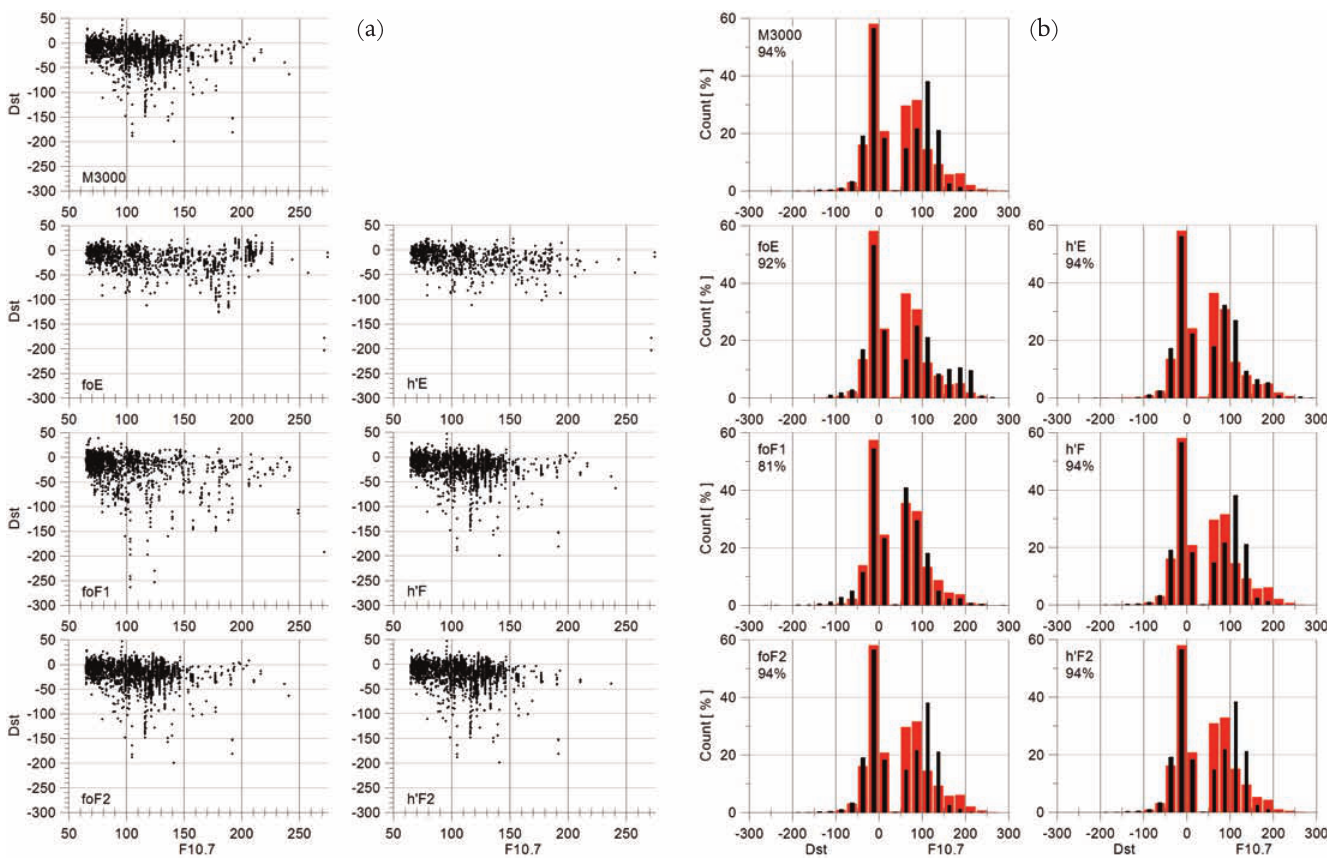
Figure 3. The digisonde autoscaling ability for different ionospheric characteristics during the period of 2002 to 2008. (A) Failed autoscaling, Dst [nT] versus F10.7 [10-22 Wm-2Hz-1]. (B) Distribution of the failed autoscaling (black) and the number of autoscaled values (red) with respect to the Dst (left) and the F10.7 (right). The percentages of the autoscaled values are given below the label for each